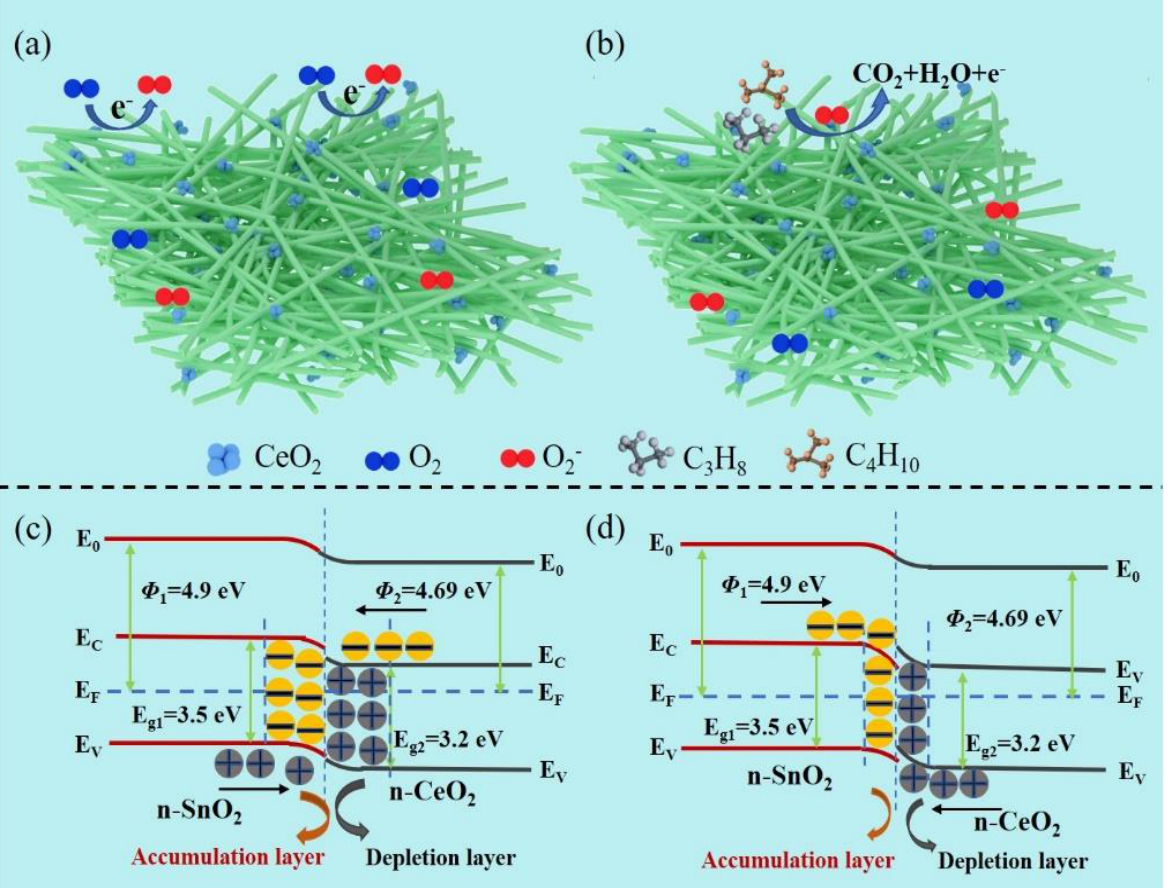
Figure 9. Schematic of the LPG sensing mechanism for the SnO 2 /CeO 2 sensor exposed to ( a ) air and ( b ) LPG. Energy band structure diagrams of the SnO 2 /CeO 2 composite in ( c ) air and ( d ) LPG atmospheres.